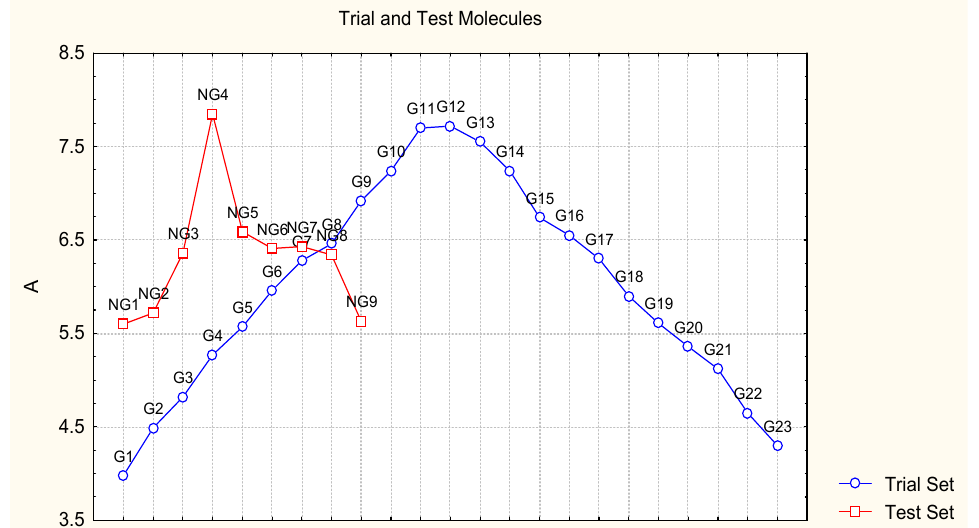
Figure 1. Gaussian (G) and non-Gaussian (NG) screening of the observed activities of the working molecules in Table 4 grouped into trial and test congener